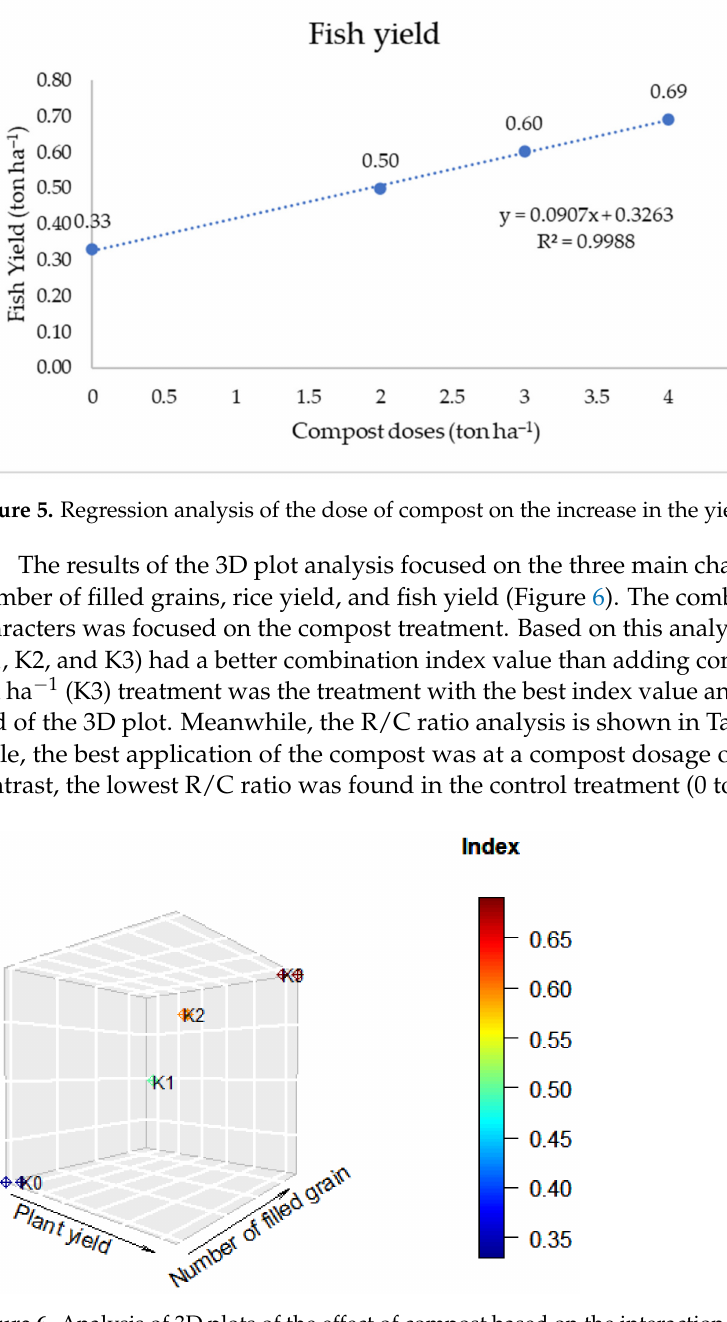
Figure 6. Analysis of 3D plots of the effect of compost based on the interaction of the number of filled grains, the fish yield, and the rice yield. Table 7. Analysis of land income on compost treatment in Minapadi